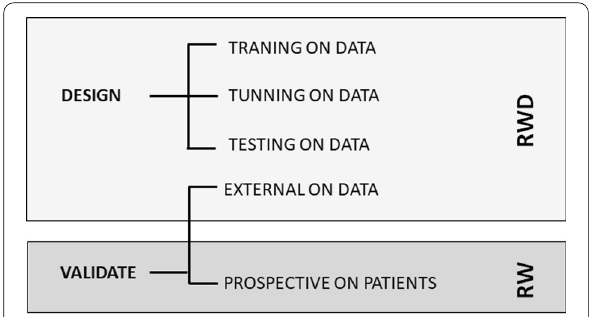
Fig. 4 Scheme of the main clinical validation steps in real world data